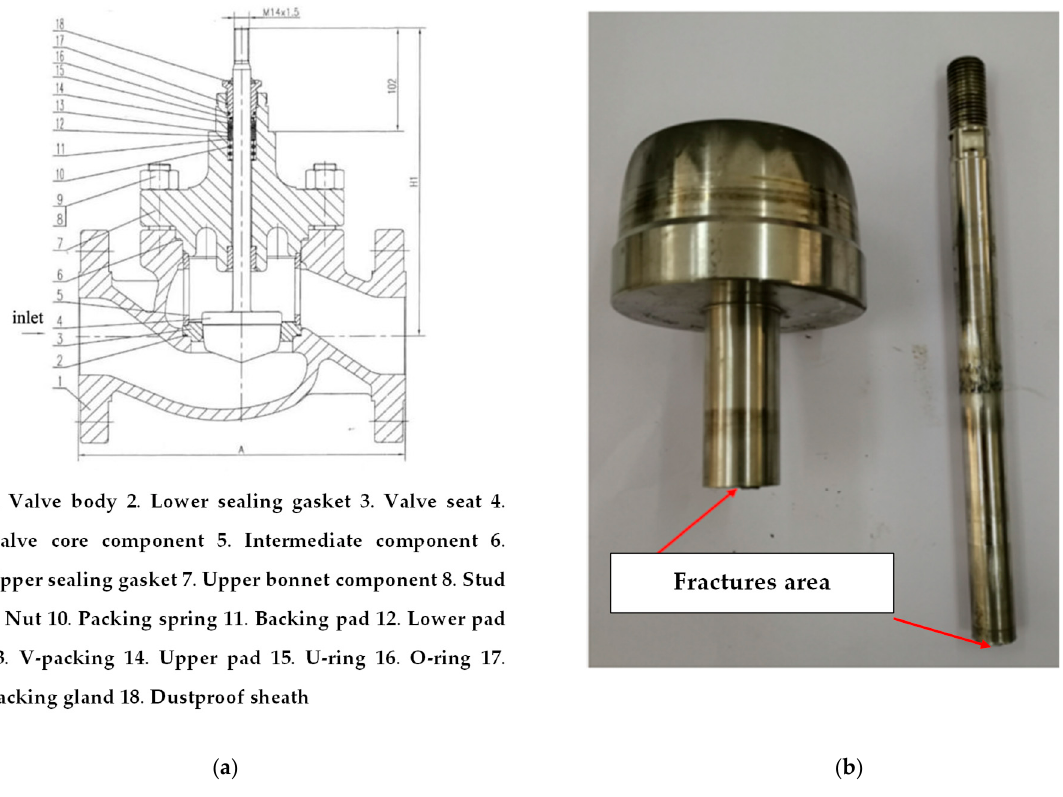
Figure 2. Diagram of the studied regulating valve; ( a ) Structural diagram of the regulating valve; ( b ) Fractured stem of the regulating valve. Table 1. Regulating valve openings and working